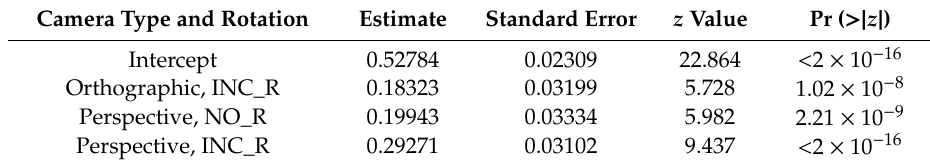
Table 10. Logistic regression analysis results by pairing the camera type and